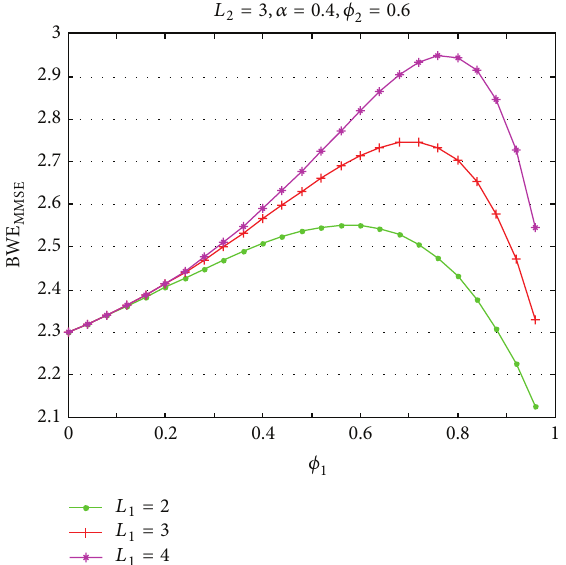
Figure 6: Impact of 𝜙 1 on bullwhip effect for different 𝑘 under the